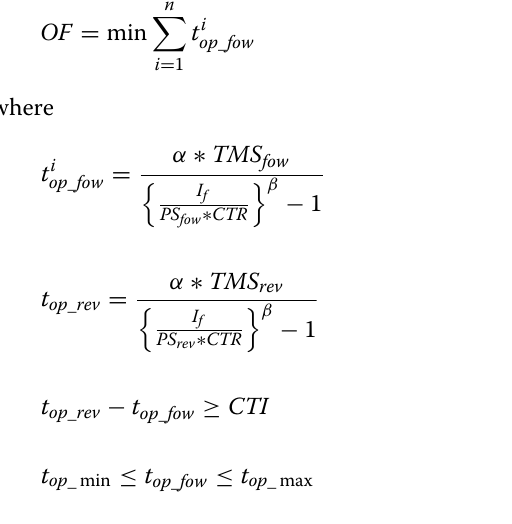
characteristics